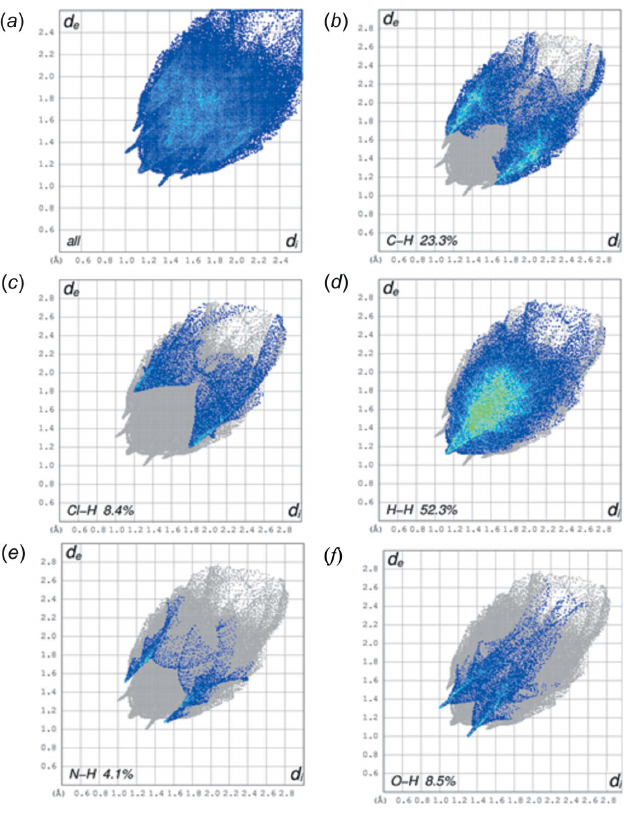
Figure 5 Fingerprint plot of the title compound, ( a ) all, ( b ) H (cid:3)(cid:3)(cid:3) H, ( c ) C (cid:3)(cid:3)(cid:3) H/ H (cid:3)(cid:3)(cid:3) C, ( d ) O (cid:3)(cid:3)(cid:3) H/H (cid:3)(cid:3)(cid:3) O, ( e ) Cl (cid:3)(cid:3)(cid:3) H/H (cid:3)(cid:3)(cid:3) Cl and ( f ) N (cid:3)(cid:3)(cid:3) H/H (cid:3)(cid:3)(cid:3) N contacts. The outline of the full fingerprint plots is shown in grey. d i is the closet internal distance from a given point on the Hirshfeld surface and d e is the closest external contact.